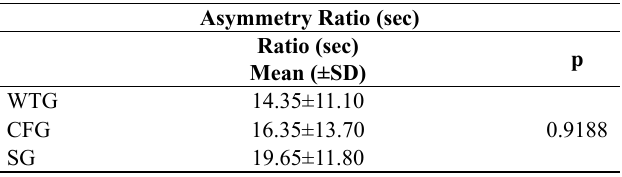
Table 2. Mean values and standard deviation of the groups in asym - metry ratio.